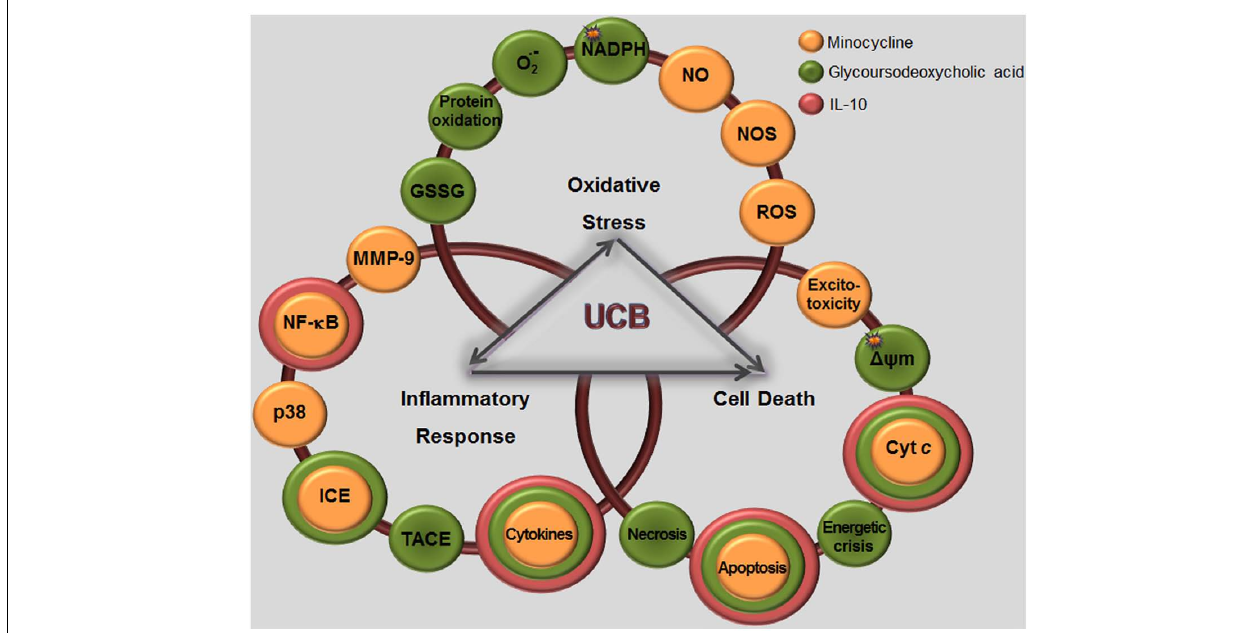
FIGURE 10 | Shematic representation of some potential neuroprotective, antioxidant, and anti-inflammatory adjunctive therapies for preventing bilirubin-induced neurological dysfunction. Given the marked oxidative stress, neuroinflammatory response, and cell death elicited by unconjugated bilirubin (UCB) in neurons and glial cells, it will be interesting to revise the potentialities of some particular antioxidants and immunomodulatory agents such as the interleukin (IL)-10, the bile acid glycoursodeoxycholic acid (GUDCA), and the antibiotic minocycline. IL-10 revealed to reduce the UCB-induced release of cytokines such as tumor necrosis factor (TNF)- α and IL-1 β , as well as nuclear factor-kappaB (NF- κ B) activation and translocation to the nucleus. In other conditions, IL-10 prevented apoptosis through the inhibition of the cytochrome c (Cyt c ) release and of the caspase-3 cleavage, pointing to its antiapoptic properties. Neuroprotective effects of the synthetic tetracycline minocycline include: (i) cytoprotective, by decreasing glutamate and excitotoxicity; (ii) anti-apoptotic, by reducing the release of Cyt c and therefore apoptosis; (iii) anti-inflammatory by decreasing the activity of the metalloproteinase-9 (MMP-9), of caspase-1 or IL-1 β converting enzyme (ICE) and of NF- κ B, and specifically directed to UCB immunostimulation